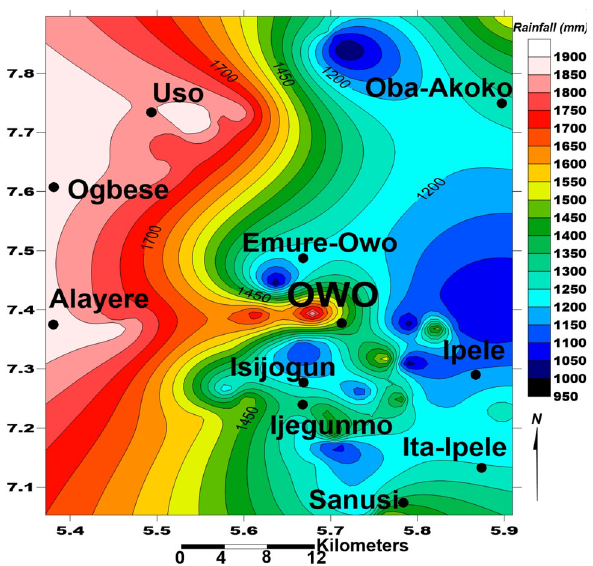
Fig. 9 Rainfall map of the study area